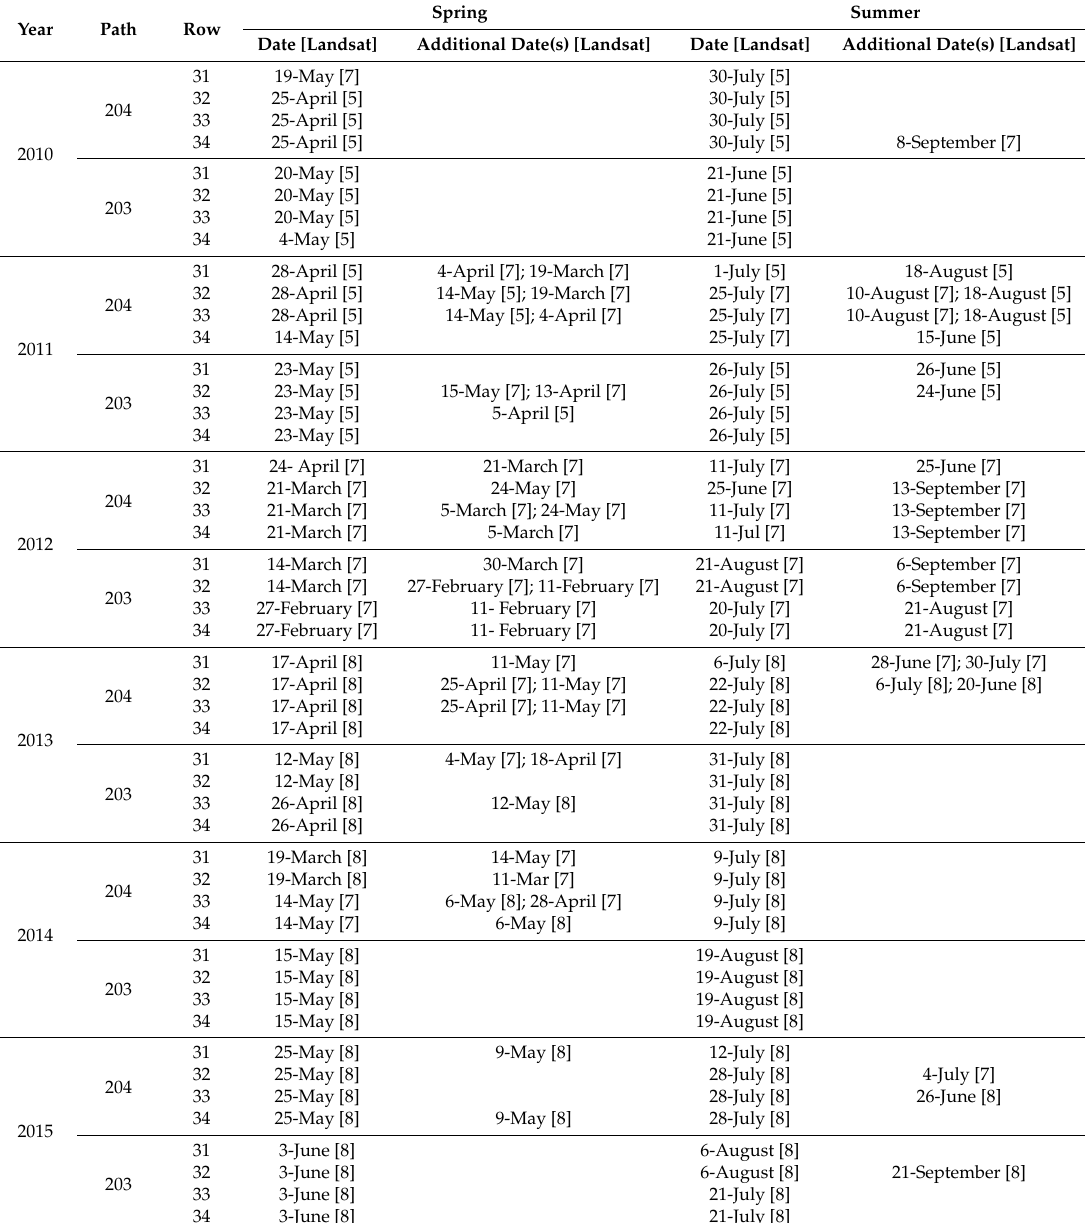
Table 2. Landsat